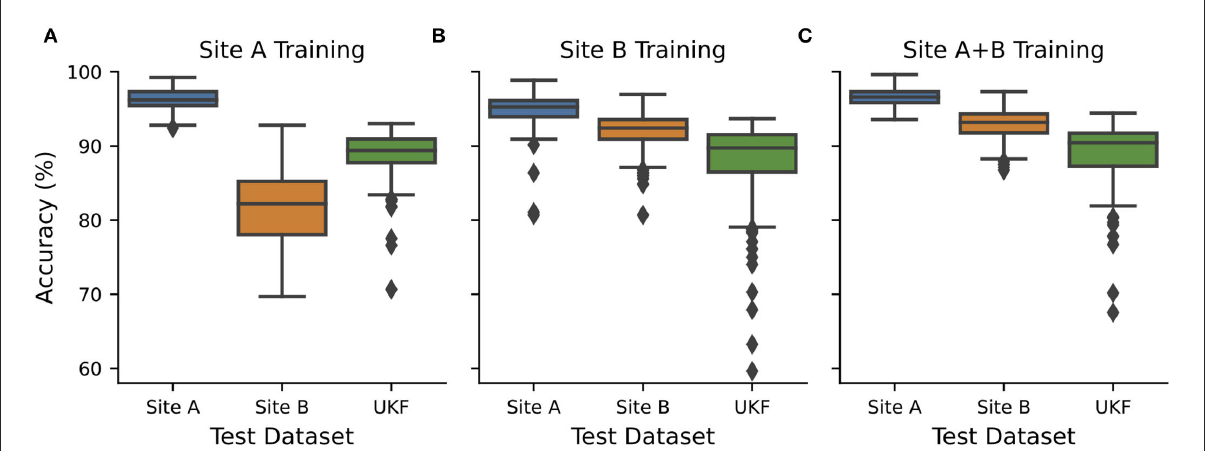
FIGURE2 CNN transferability depended on the quality of training data. CNNs were exclusively trained and validated on data from (A) source site A ( n = 21 + 7), (B) source site B ( n = 27 + 7), or (C) both source sites ( n = 48 + 14) and tested on hold-out test data from site A ( n = 7) and site B ( n = 7) and external data from UKF. Hold out test data were randomly chosen 10 times and every test 15 individual CNNs with different train-validation splits were calculated and the performance was measured. Boxplots show all recorded performances. Blue…site A; orange…site B; green…UKF.